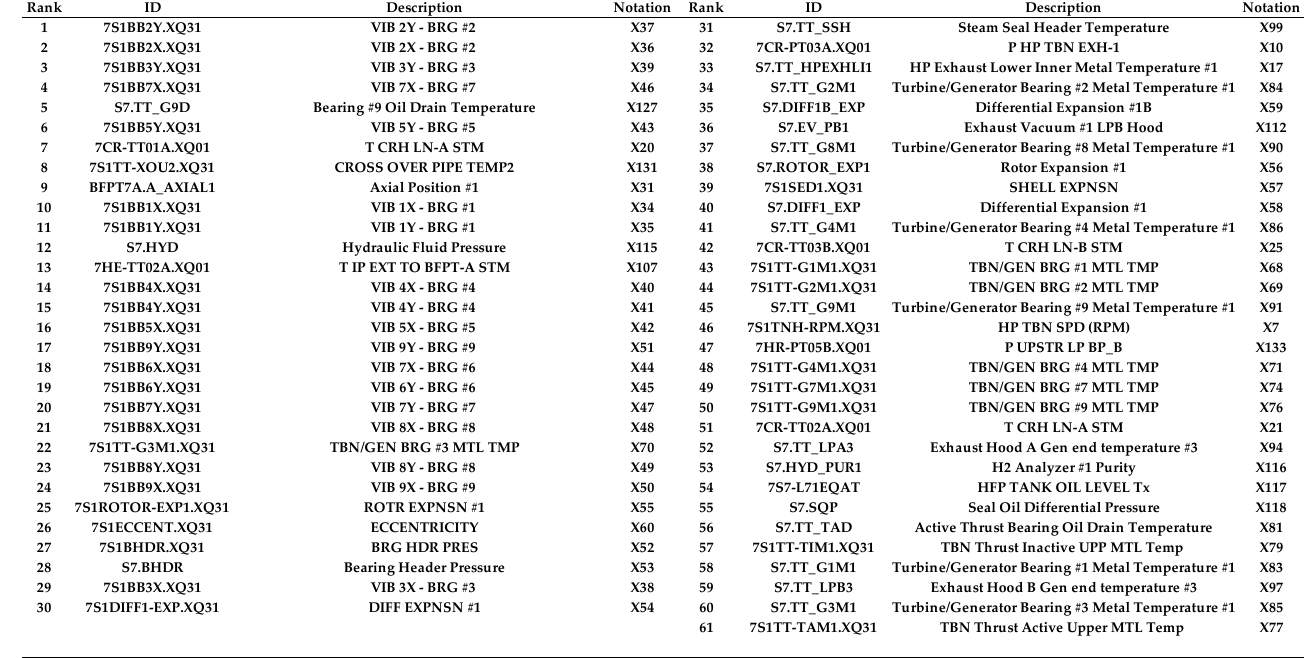
Figure 20. List of optimal sensors selected by extra-tree algorithm. Table 6. Case scenarios for the machine-learning